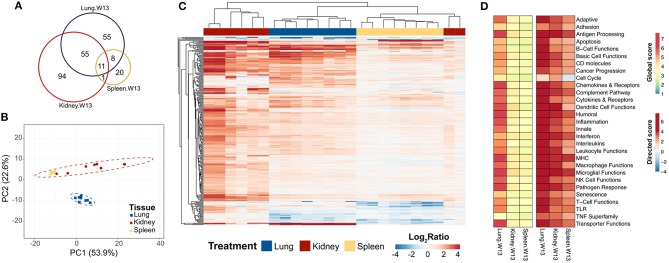
Comparison of chronic transcriptional response of immune-associated genes in lung, kidney and spleen tissues of mice 13 weeks post instillation with cSiO2. Mice received four repeated weekly doses of cSiO2 or saline vehicle (VEH) via intranasal instillation, and gene expression was determined in lung, kidney and spleen tissues obtained 13 weeks post instillation. (A) Venn diagram depicting the number of genes identified as differentially expressed in lung, kidney, and spleen tissues 13 days post installation as compared to time-matched, vehicle-exposed mice. (B) Principal components analysis of differentially expressed genes (BH q < 0.05, log2 ratio >1 or < −1) in lung, kidney, and spleen tissues of cSiO2-exposed mice compared to time-matched vehicle controls. PC1 and PC2 are shown with 95% confidence intervals (dashed ellipses). (C) Unsupervised, bidirectional hierarchical cluster analysis of lung, kidney, and spleen immune pathway transcriptome data using the Euclidean distance method with average linkage. All genes differentially expressed in any one of the tissue types were included in the heatmap, which is colored by the log2 ratio as calculated with respect to average expression in time-matched vehicle controls. (D) Heatmaps depicting either global or directed significance scores for immune-related pathways (see Materials and Methods for details on calculation of significance scores).